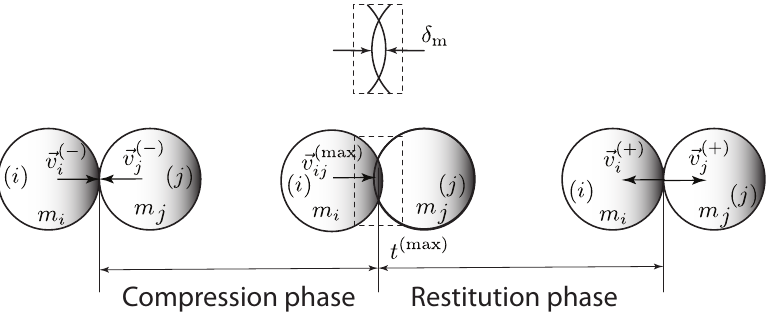
Figure 4. Central collision between two circular-shaped masses: representation of the compression and restitution phase